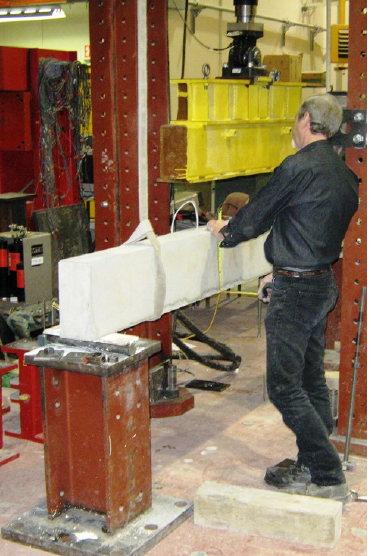
Figure 2. Placement of a concrete beam to be used for the experiment